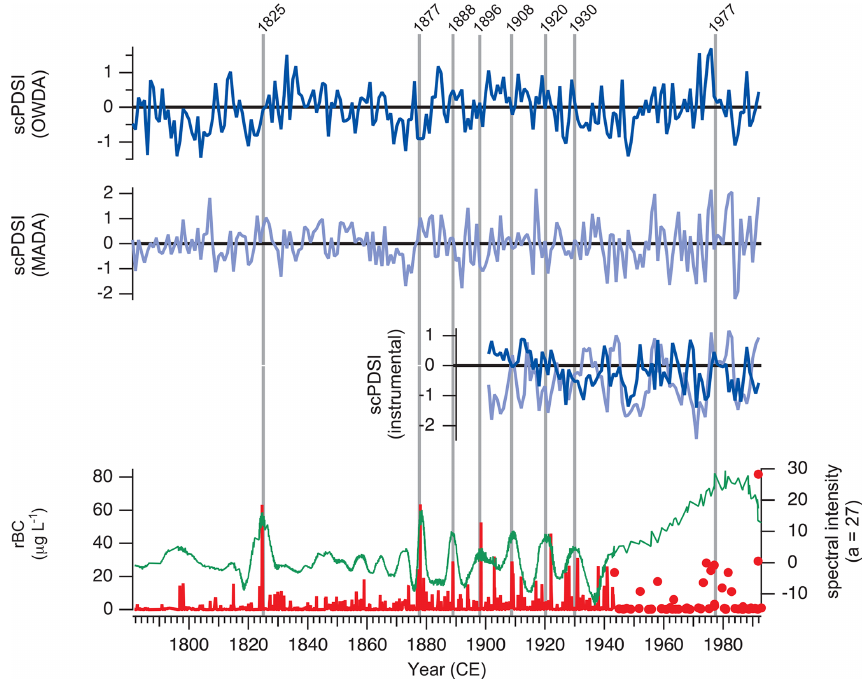
Figure 6. The Dasuopu rBC record (in red) compared to regional reconstructed and instrumental climate records from the Old World Drought Atlas (OWDA; dark blue) and the Monsoon Asia Drought Atlas (MADA; light blue). Note the correspondence between a negative self-calibrating Palmer Drought Severity Index (scPDSI) and periods of high rBC deposition. Data for both the reconstructed and instrumental climate records are obtained from the OWDA (drought.memphis.edu/OWDA/) and MADA